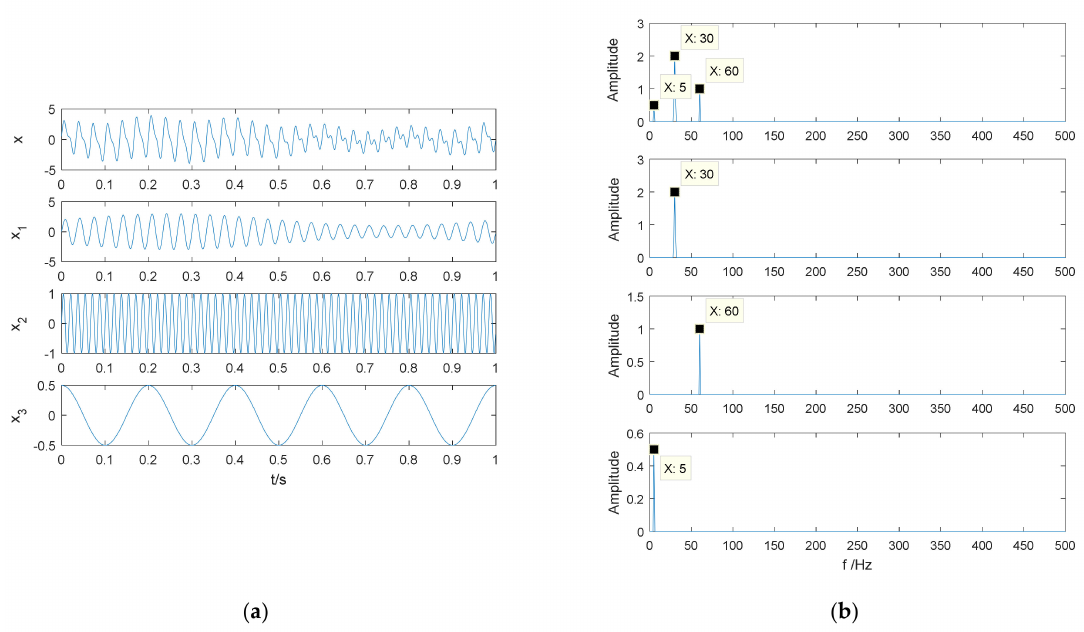
Figure 2. Simulation signal. ( a ) Time domain; ( b ) Frequency domain.